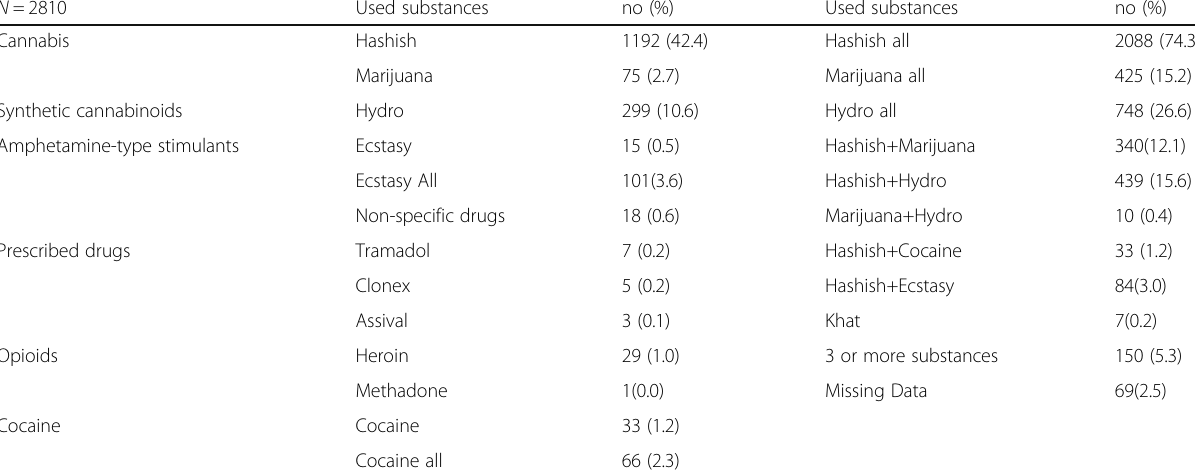
Table 4 Substances used by suspected persons captured with seized substances in the years 2010 –